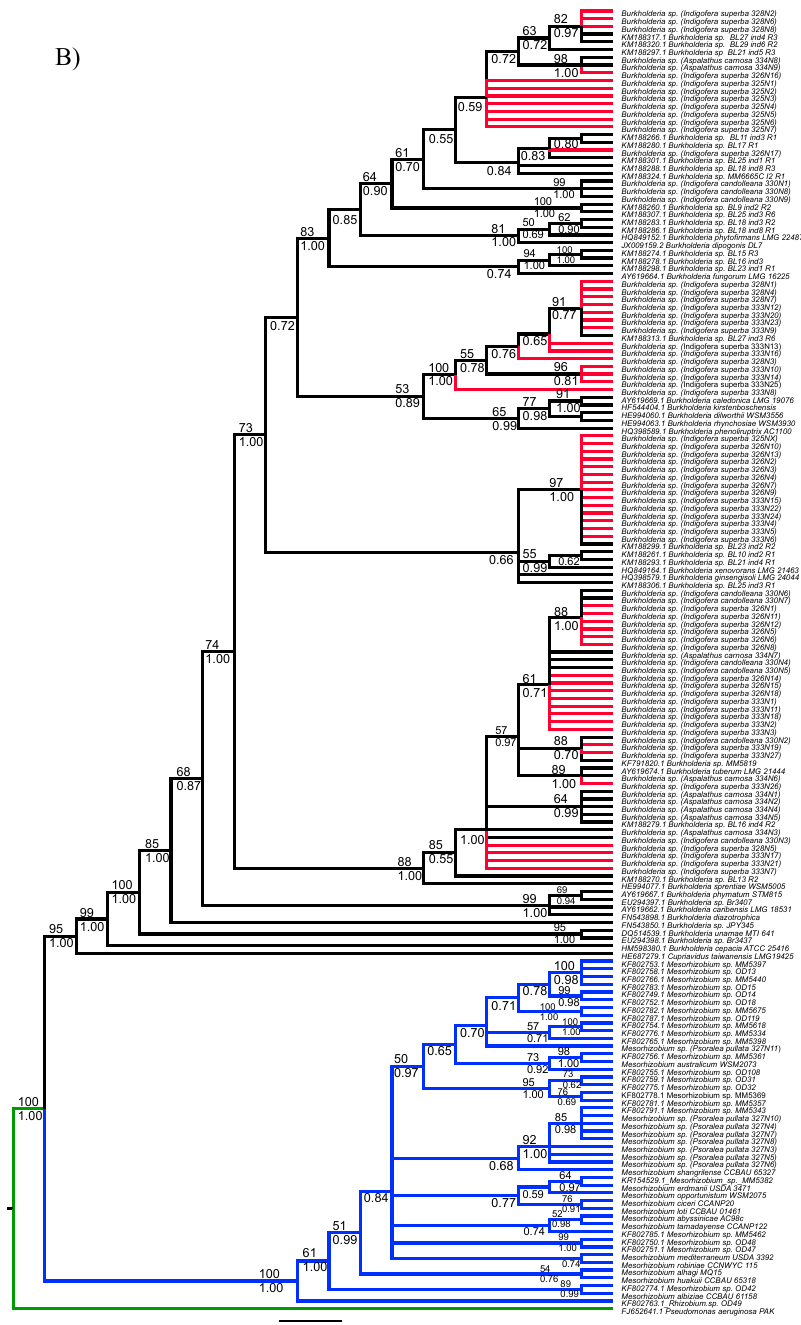
Figure 5. ( A ) Phylogenetic relationships of rhizobial strains based on recA data, showing the phylogenetic position of strains isolated from Indigofera superba (red nodes) in relation to rhizobial strains of other legumes in the CCR, blue: Mesorhizobium strains; black: Burkholderia , green: outgroup. ( B ) Detailed version of Figure 5A), showing the tip labels and ML Bootstrap support values (%) above the nodes and Bayesian posterior probabilities, below the branches.